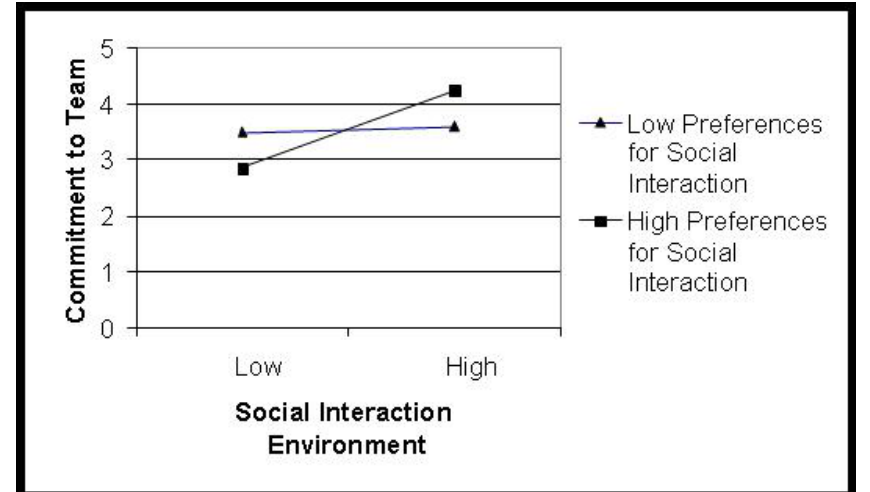
Figure 3. The interactive effect of preferences for social interaction and the social interaction environment on commitment to the